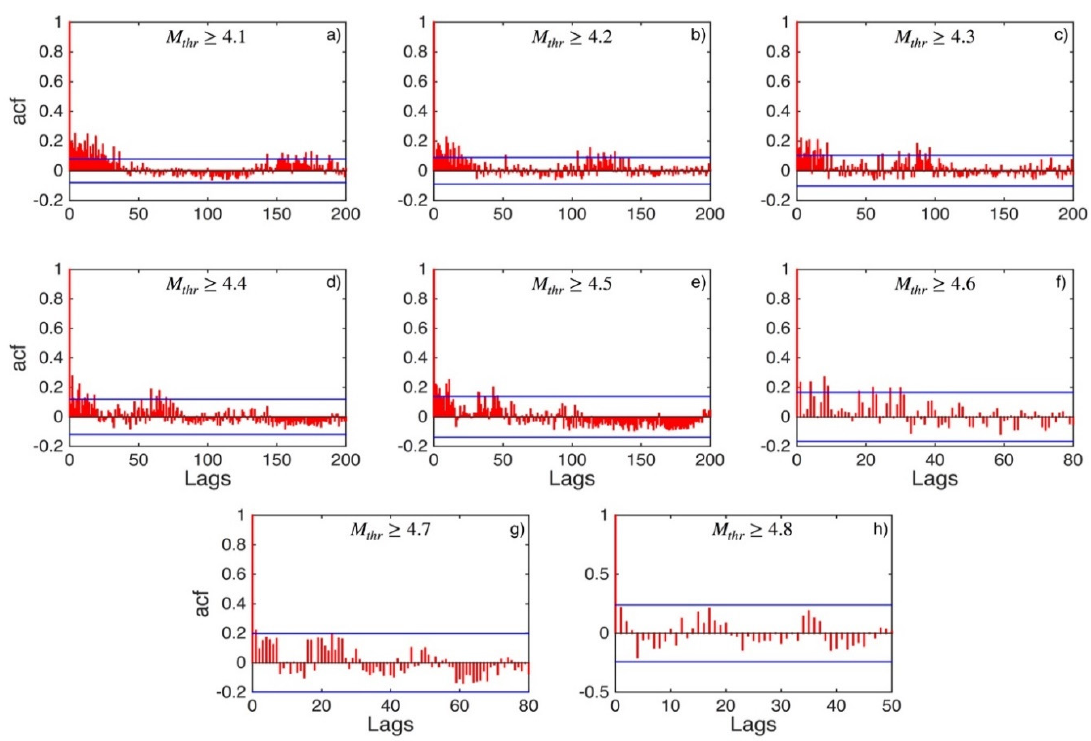
Figure A25. ACF values (red stems) and their 95% confidence intervals (blue lines) for Northern Greece and Balkans (sub-area 10) for magnitude thresholds ( M thr ) varying from 4.1 to 4.8 (subplots a – h ).